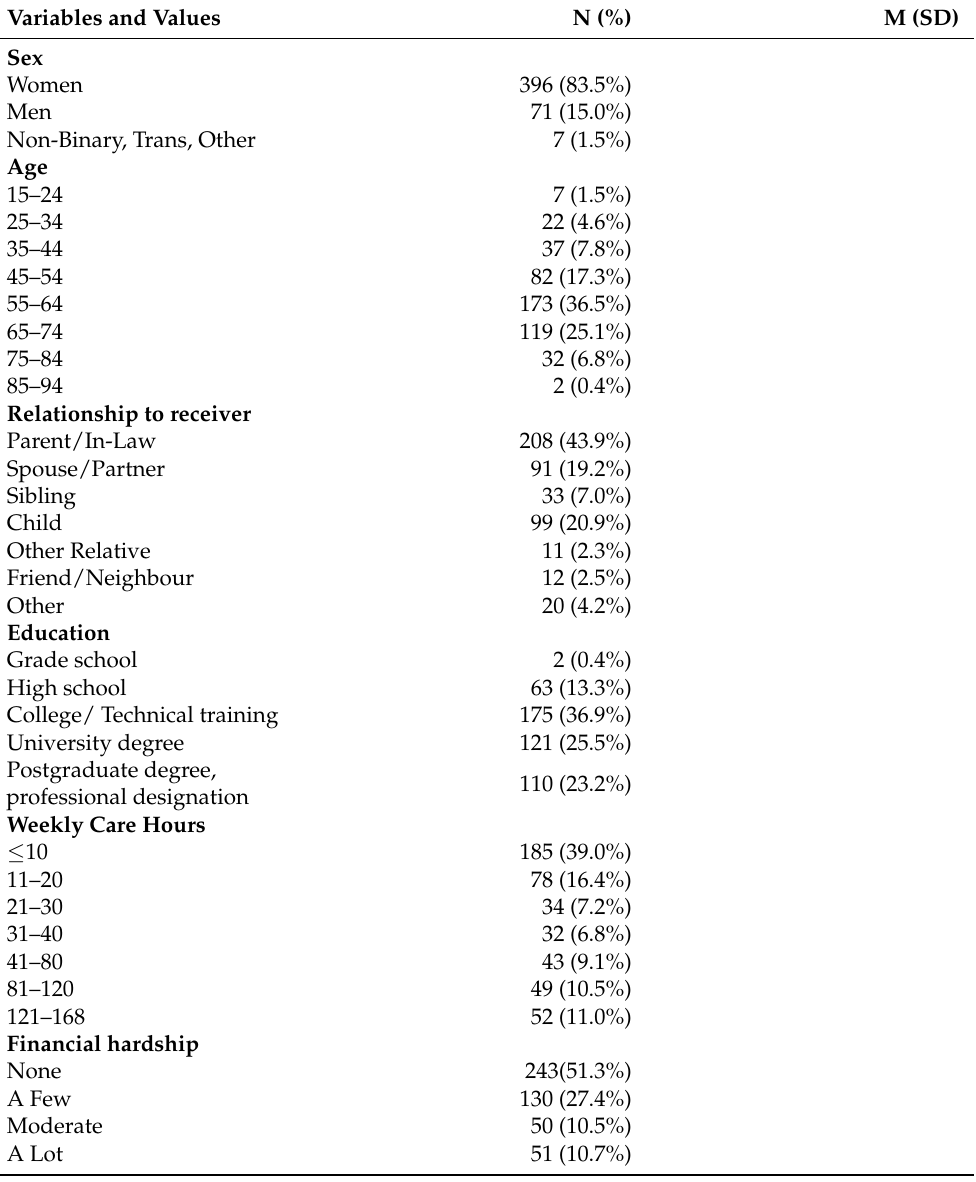
Table 1. Caregiver socio-demographic